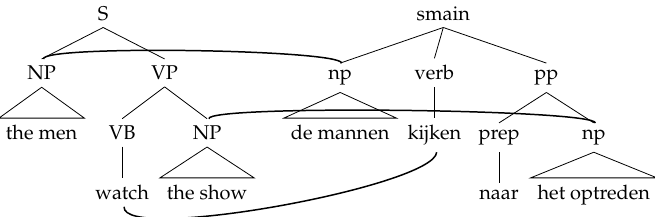
Figure 4. An example node-aligned parallel tree (Gloss of the Dutch sentence is “ the men look at the show